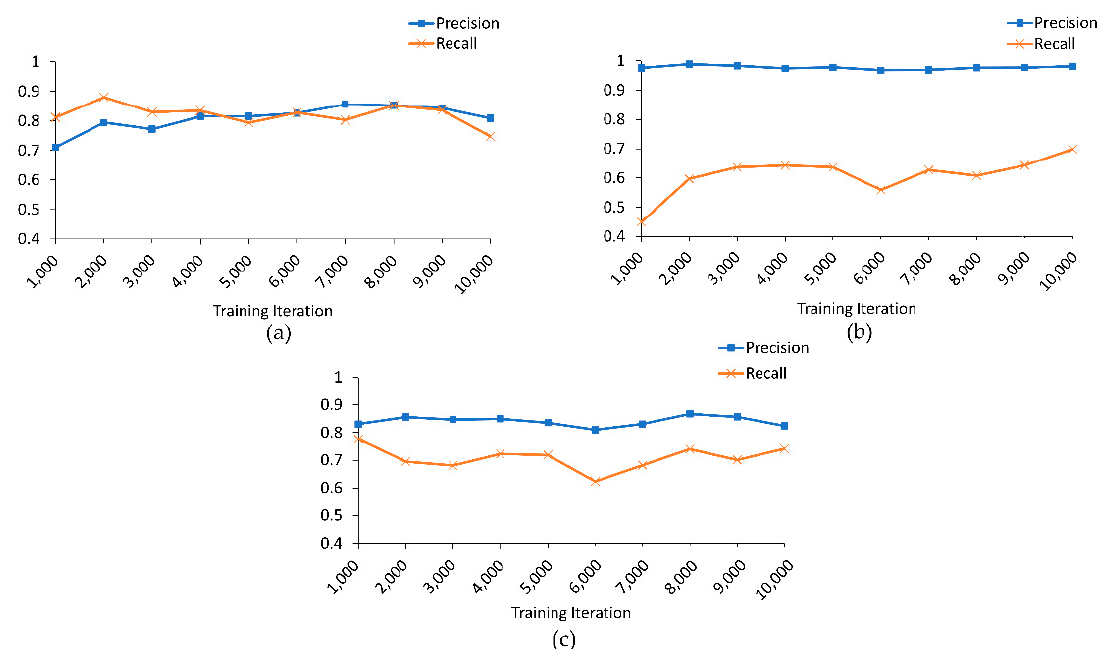
Figure 12. Precision and recall calculated for the synthetic data of ( a ) Class 1, ( b ) Class 2, and ( c ) Class 3.